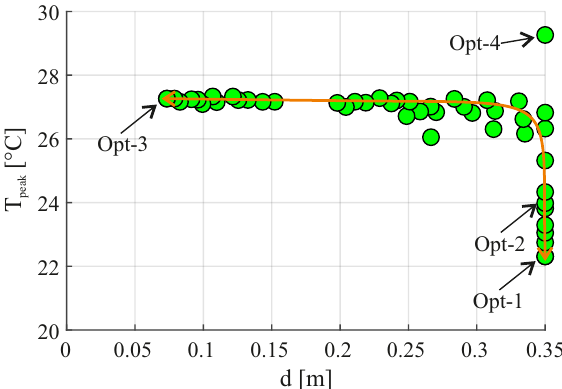
Figure 6. Relationship between optimal design variables for Case